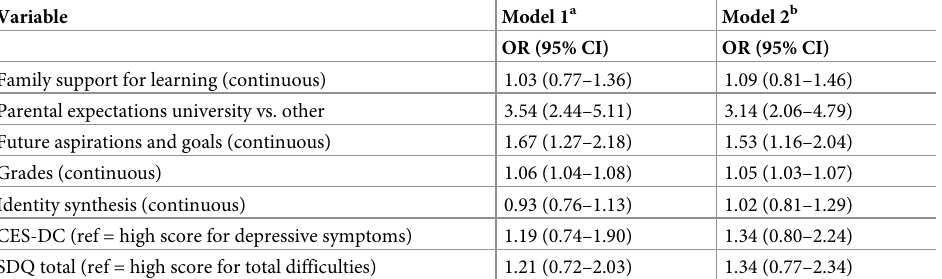
Table 4. Odds ratios and 95% confidence intervals of raised own academic expectations among adolescents reporting a definite academic expectation at baseline according to family and individual predictors (N = 595).